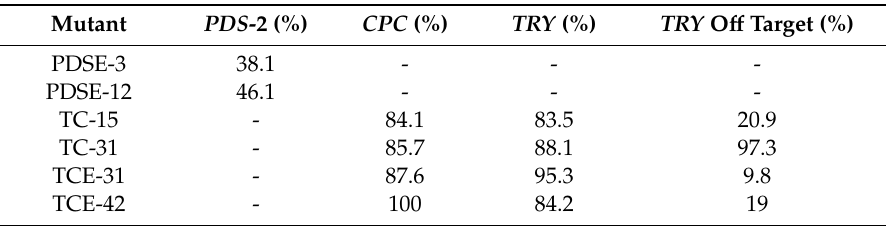
Table 3. On- / o ff -target mutation frequency of WGS.